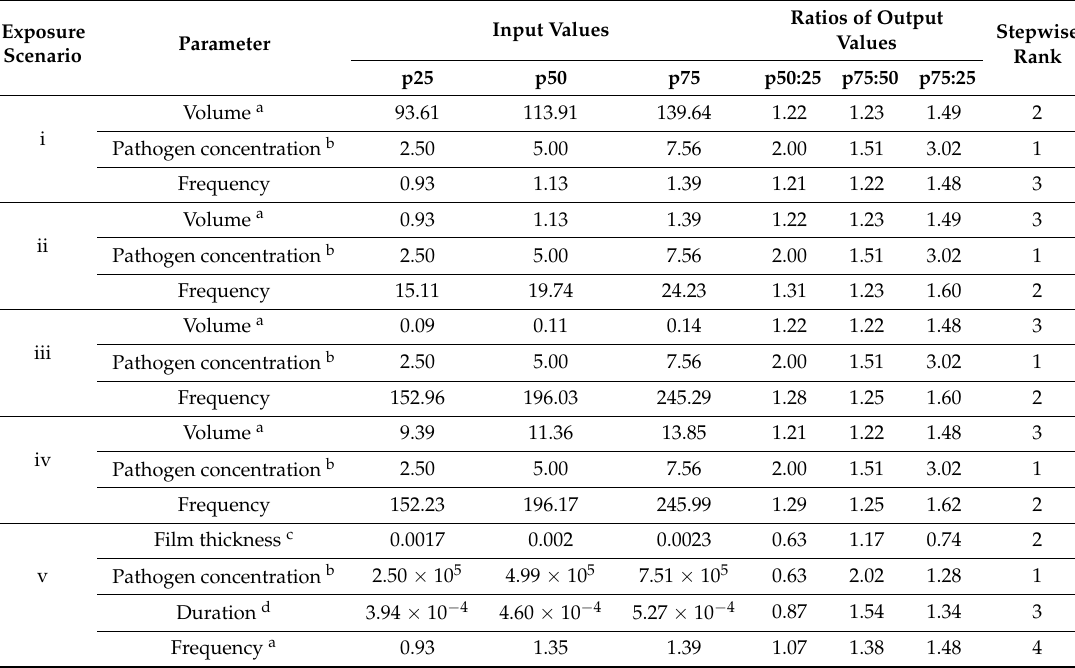
Table A2. Sensitivity analysis inputs, outputs, and stepwise rank for each